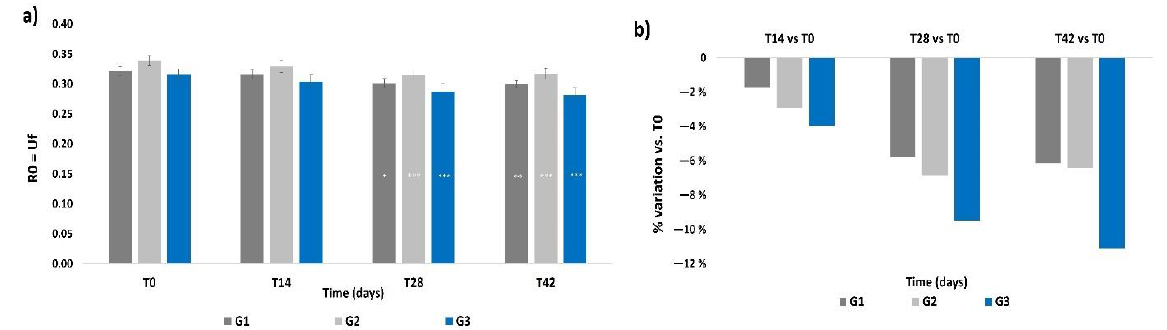
Figure 5. Skin firmness. The graphs show data obtained at each monitored time for the three groups. ( a ) Data are expressed as mean ± SEM of the R0 parameter (Uf). This parameter indicates the skin ability to oppose to the deformation imposed by the probe during the analysis. A reduction of the R0 parameter indicates an improvement of skin firmness. ( b ) Data are reported as mean percentage variation with respect to T0. Legend = *** p < 0.001 vs. T0, ** p < 0.01 vs. T0, * p < 0.05 vs. T0.